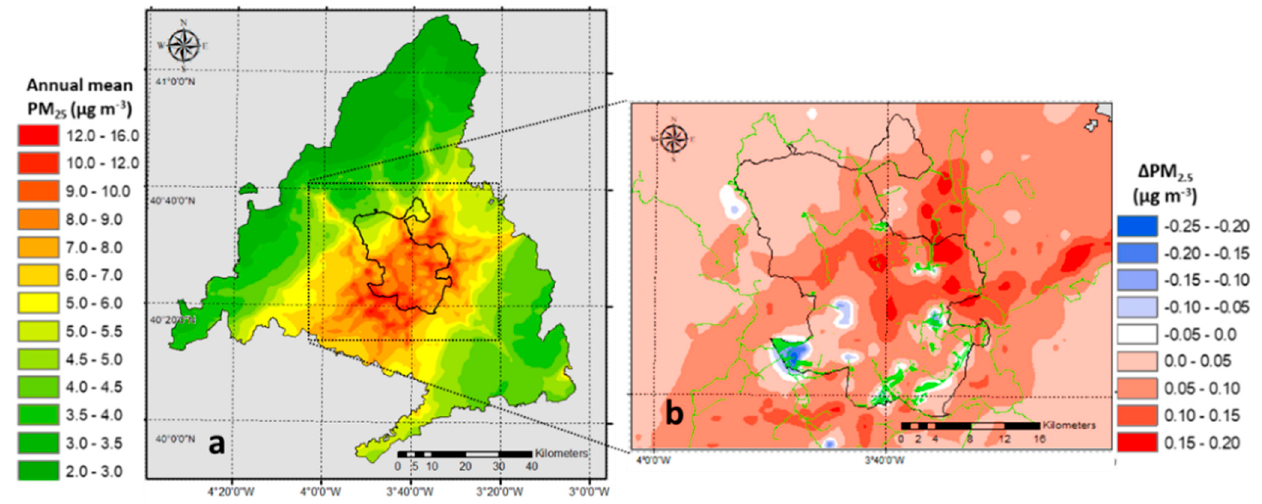
Figure 10. Annual mean of PM 2.5 (µg m − 3 ) for the Baseline Scenario ( a ) and expected variation (µg m − 3 ) due to future vegetation ( b ).